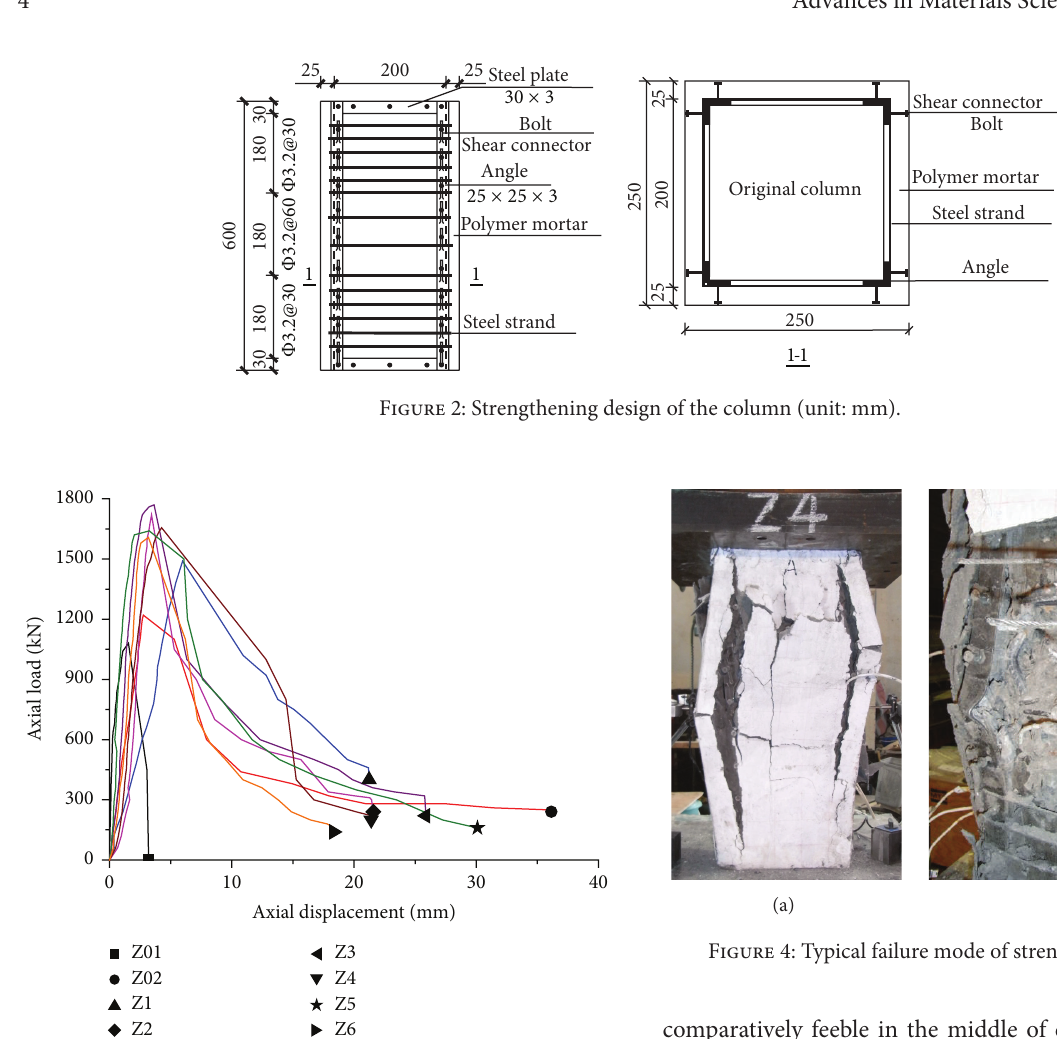
Figure 3: Load-displacement curves.